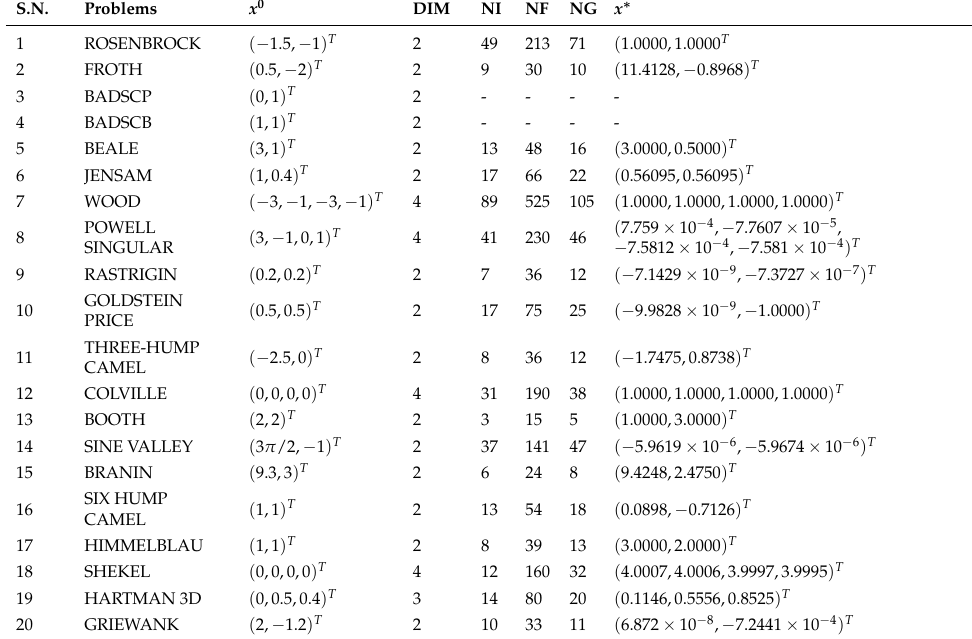
Table 9. Numerical results for BFGS algorithm.